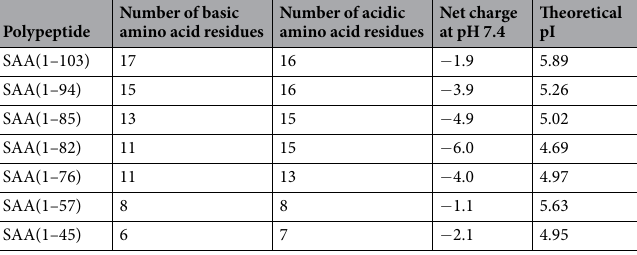
Table 1. Theoretical analysis of the amino acid sequences of SAA(1–103) and AA